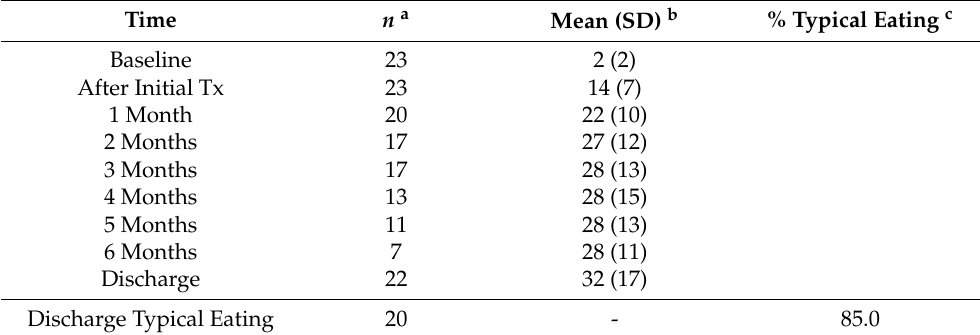
Table 4. Liquid-dependent—Number of Foods Consumed.